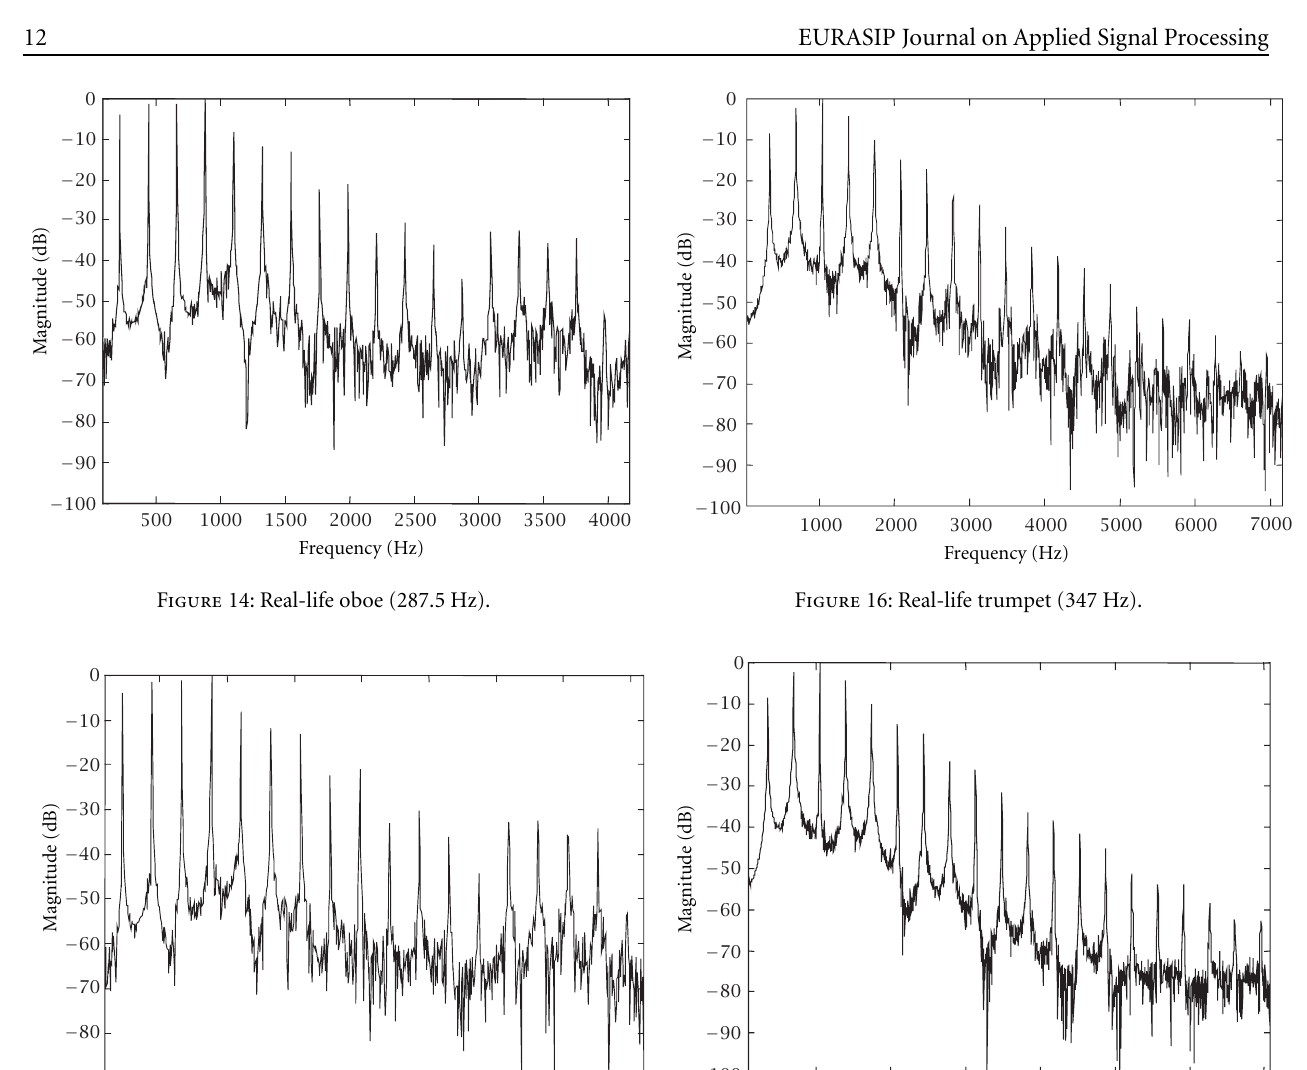
Figure 17: Synthesized trumpet (347